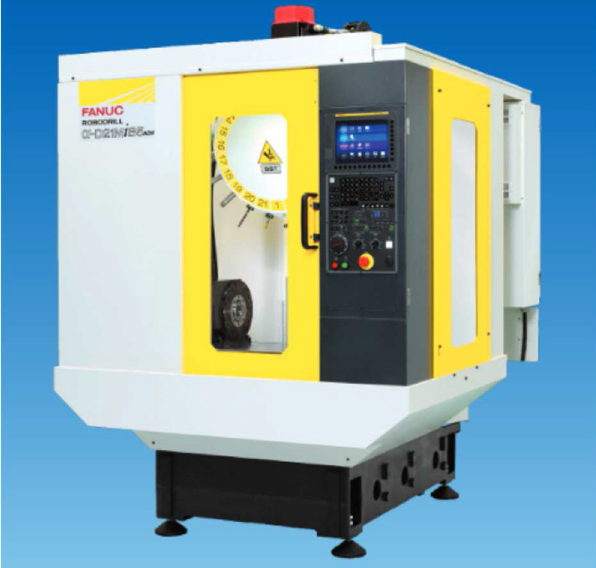
Fig. 4. Means of production for the machining of parts.